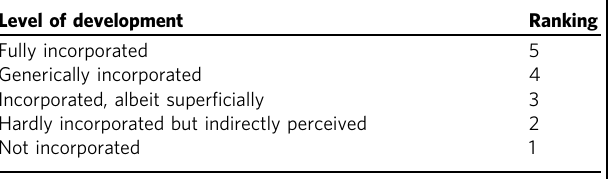
Table 2 Levels of development of the dimensions of the model and ranking.